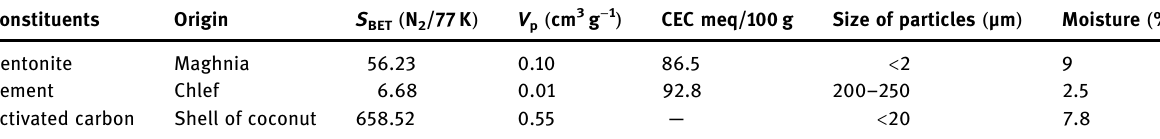
Table 1: Source of reagents and characterization of the geomaterial constituents